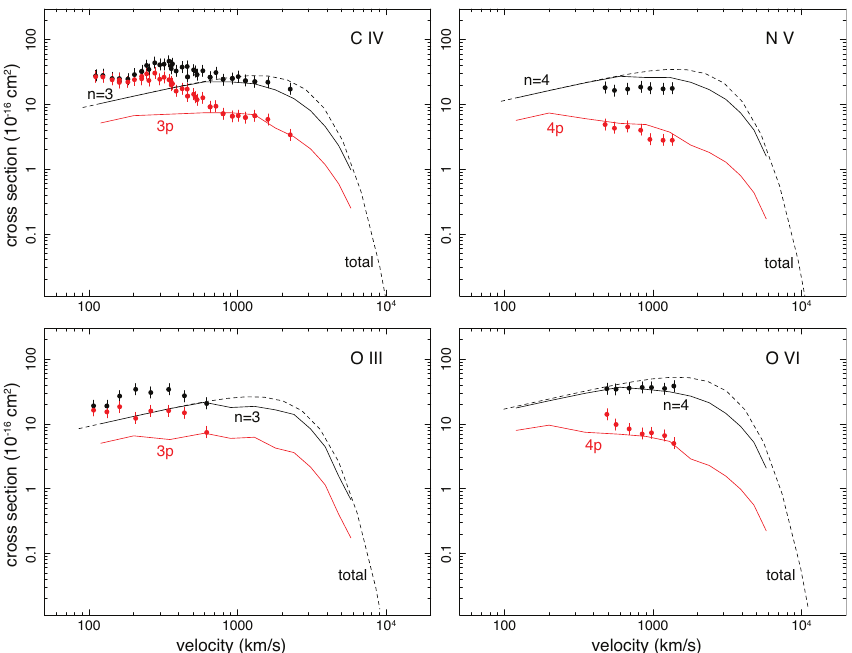
Figure 4. State-selective cross sections as a function of collision velocity for C IV, N V, O III, and O VI. The data points are taken from merged-beam experiments (see Table 1 for detail), for the peak n shells (black) and the np subshells (red). The approximate errors of 15% [43] are shown. The black solid lines are the G16 calculations of the peak n shells, and the red lines are the G16 data for the np subshells. The dash lines are the G16 calculations of the total cross